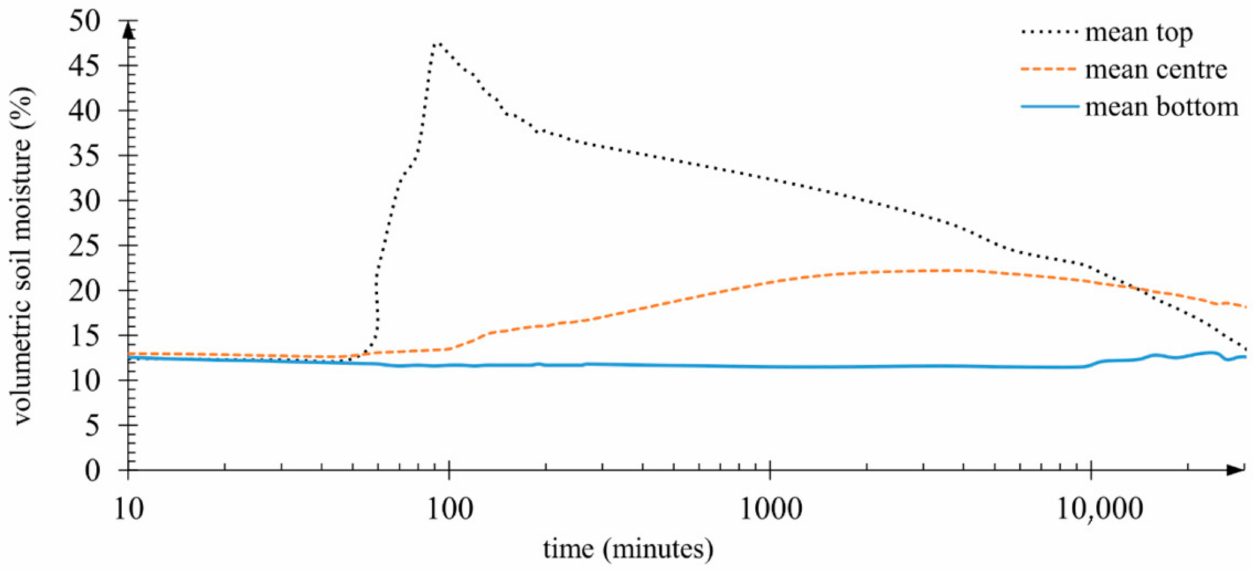
Figure 5. Soil moisture recorded in the course of the wetting–drying process in pot samples containing the mixed soil amendment SAP in the first drying cycle; visible constant moisture level in the bottom layer of the sample ( n =